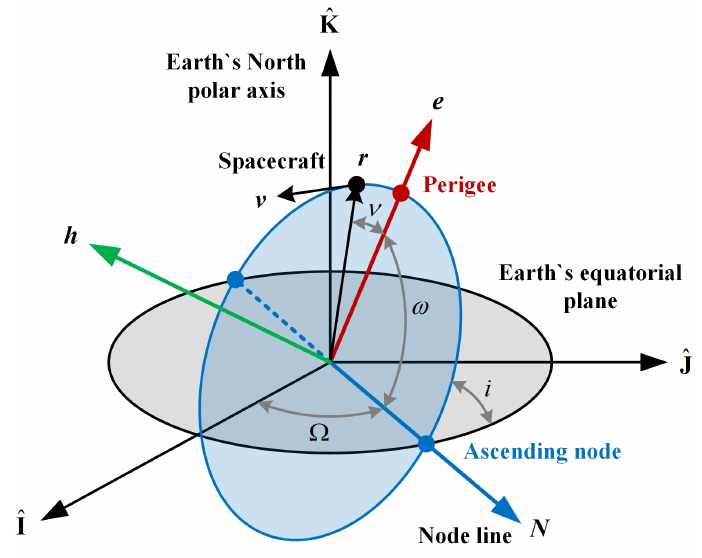
Figure 2. An illustration of the orbit